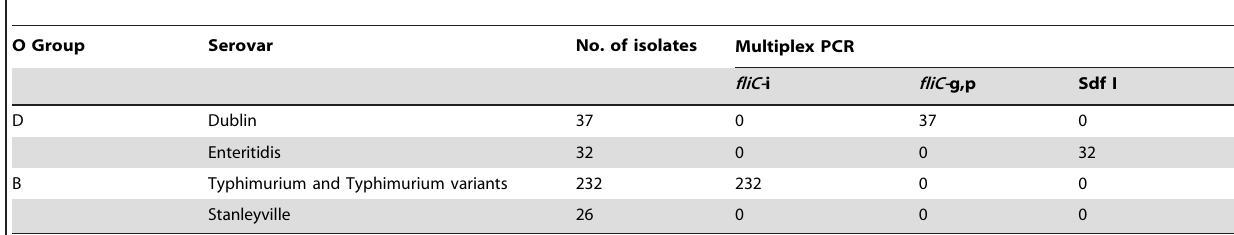
Table 3. Detection of Salmonella Typhimurium and variants, Salmonella Enteritidis and Salmonella Dublin by multiplex PCR among 69 non-Typhi Group D Salmonella and 258 Group B Salmonella isolated from blood cultures of febrile patients in Bamako,